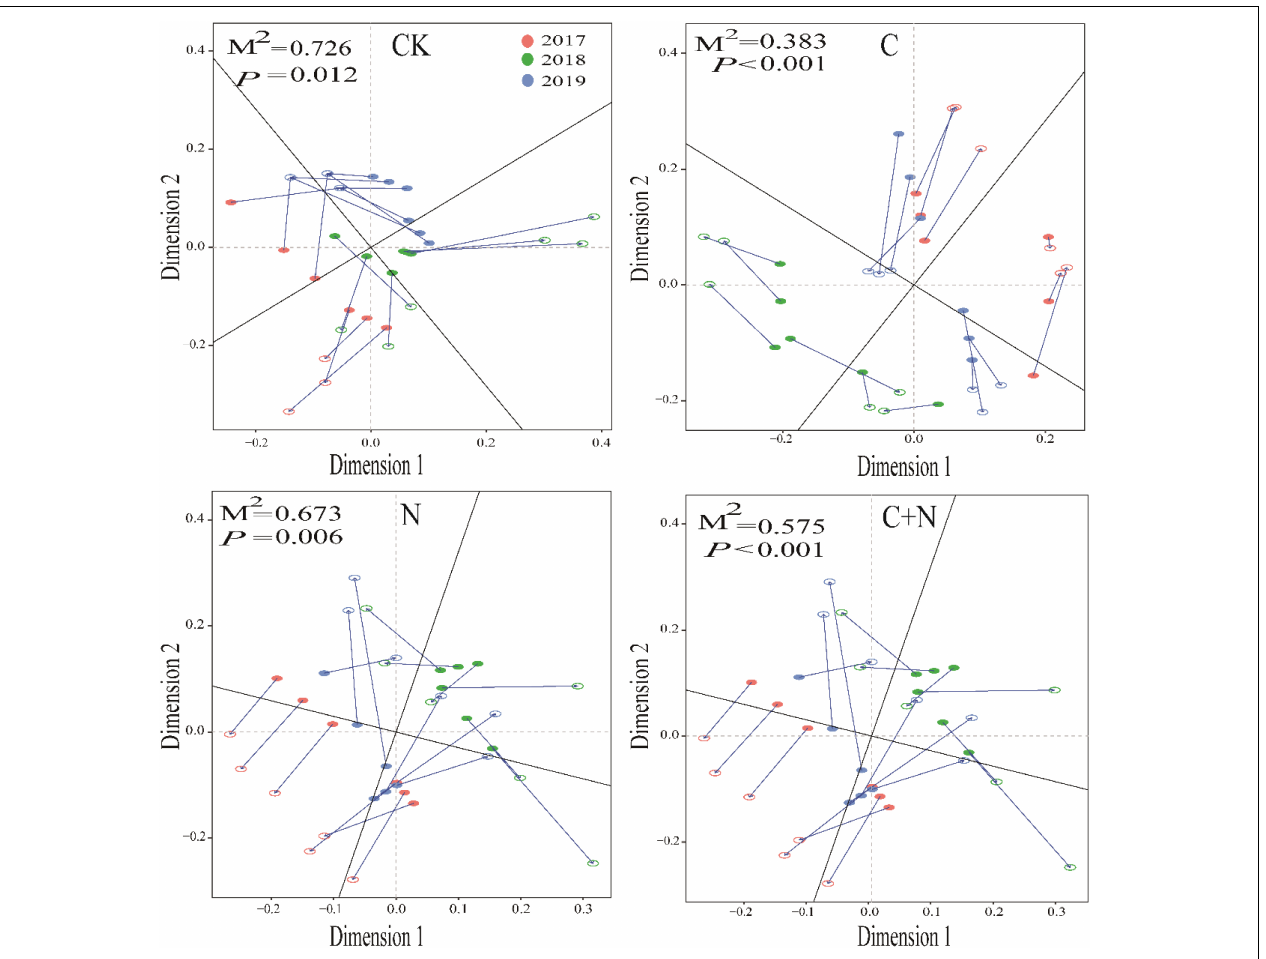
FIGURE 6 | Procrustes analysis of the correlation between soil physicochemical properties and microbial community based on the PCA (Bray–Curtis) results of different treatments.